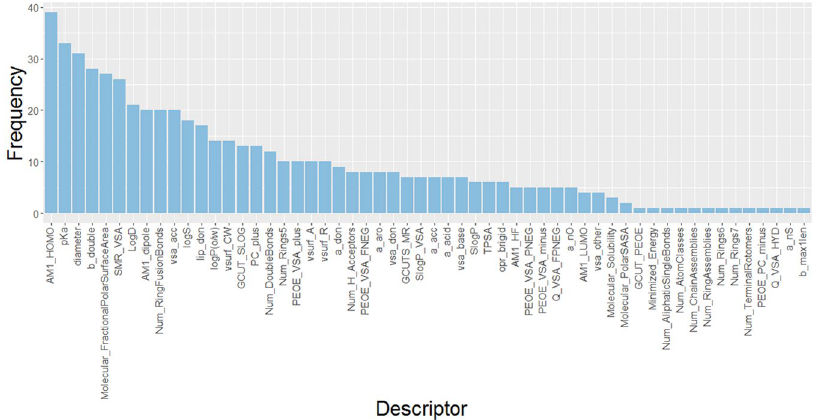
Figure 2. Frequency of descriptors in the 100th generation of the Pareto